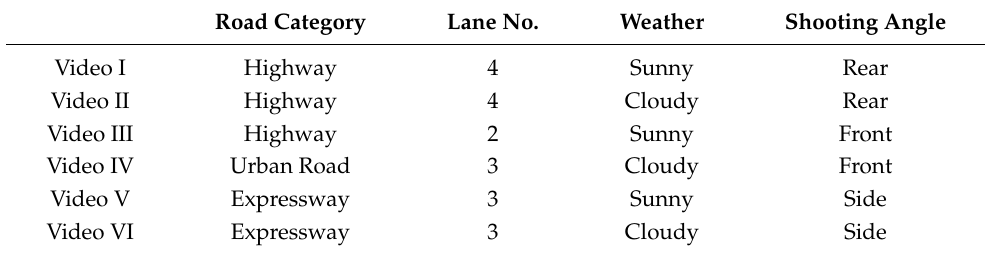
Table 8. Characteristics of the videos and the roads.